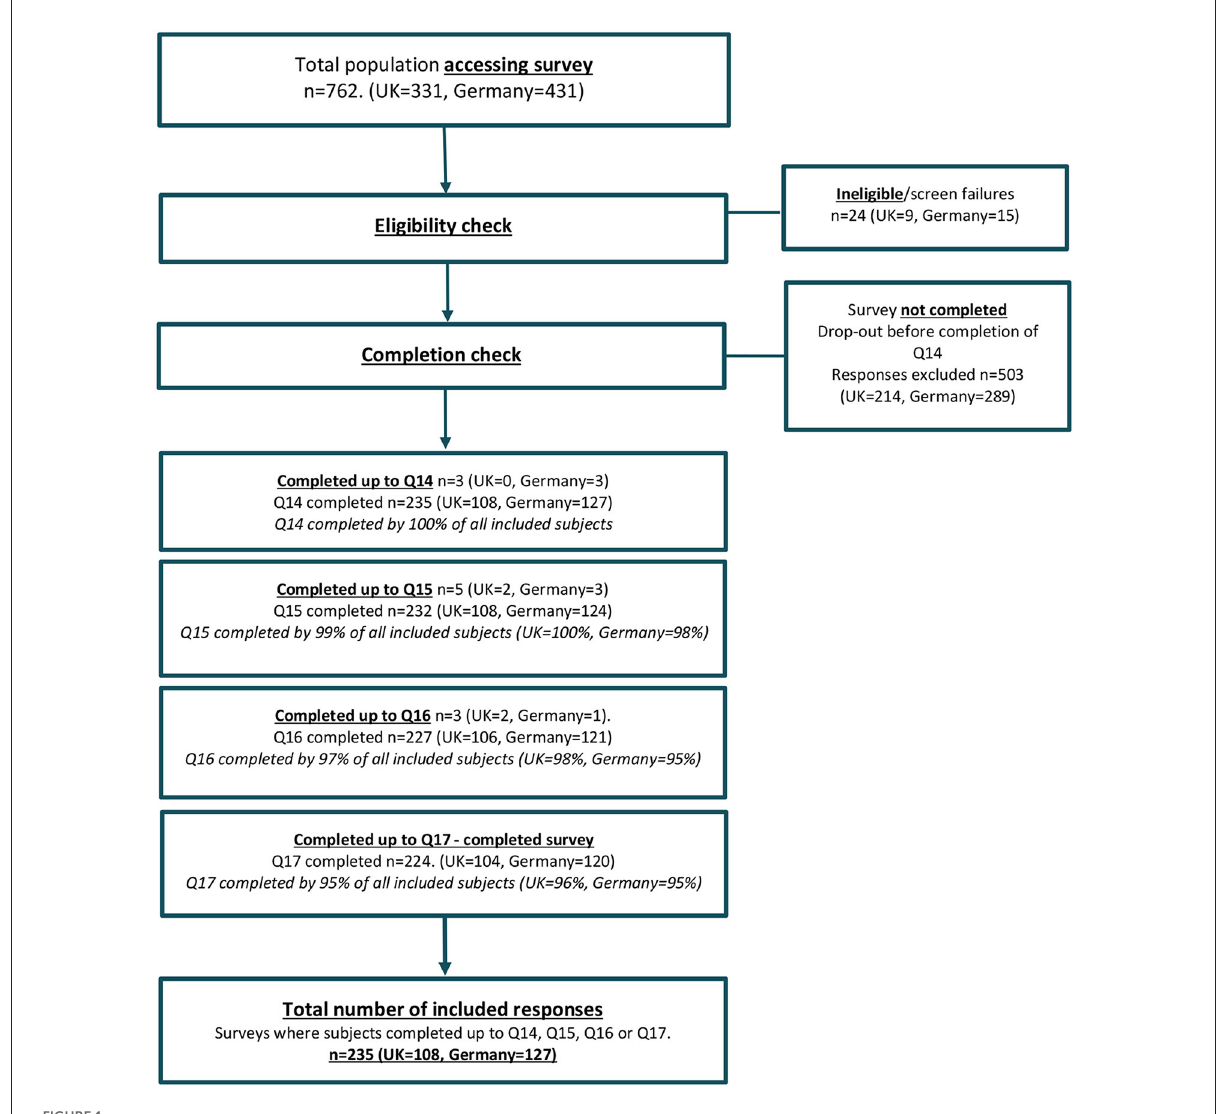
FIGURE1 Population